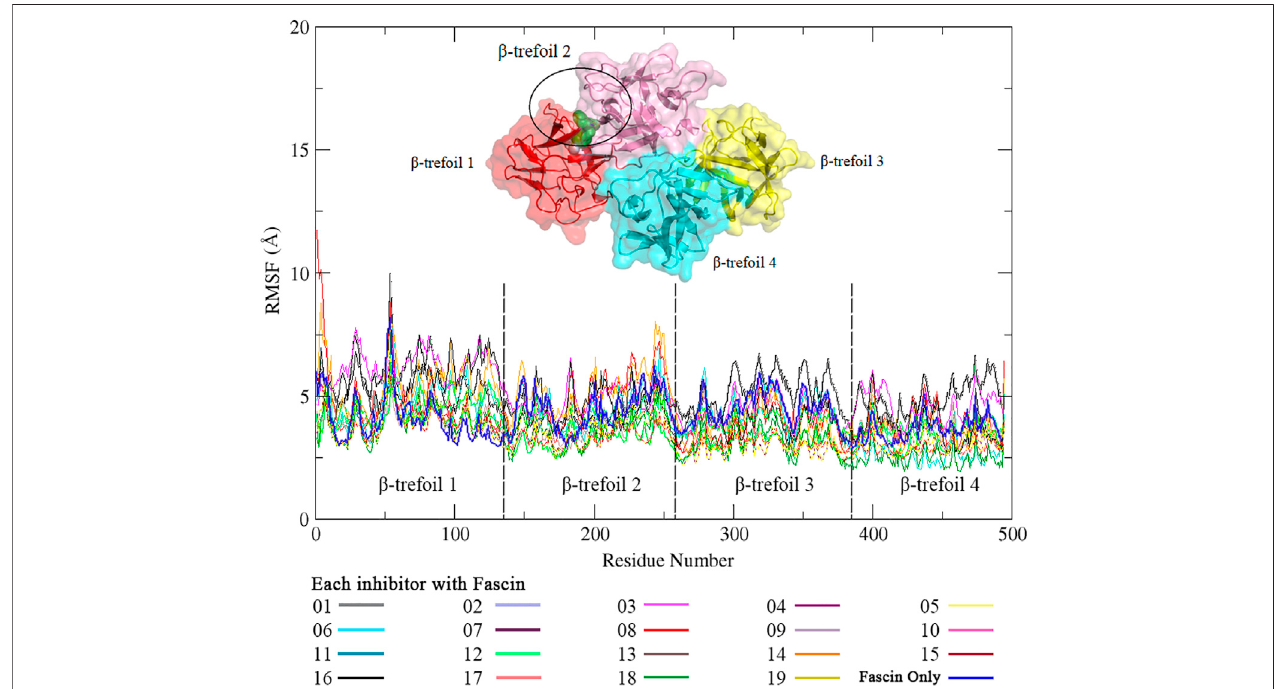
FIGURE 5 | The RMSF of residues in complex with NP-G2-029 and 18 inhibitors in conventional MD simulations. Different color lines stand for the different inhibitors.